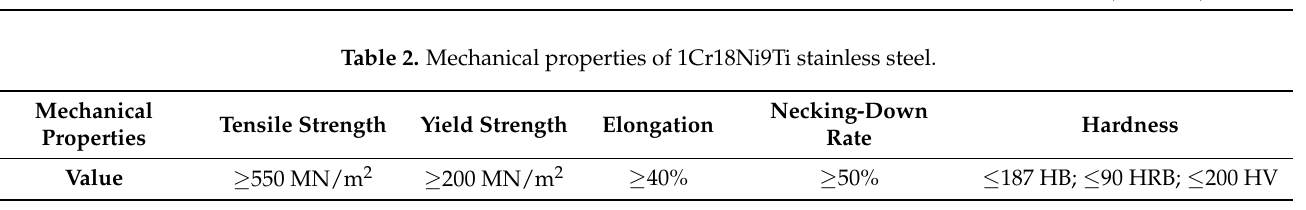
10 of 19 Figure 10. Experiment setup for micro-fillet machining. Material of blade electrode: 1Cr18Ni9Ti (Huahu Company, Shanghai, China) stain-